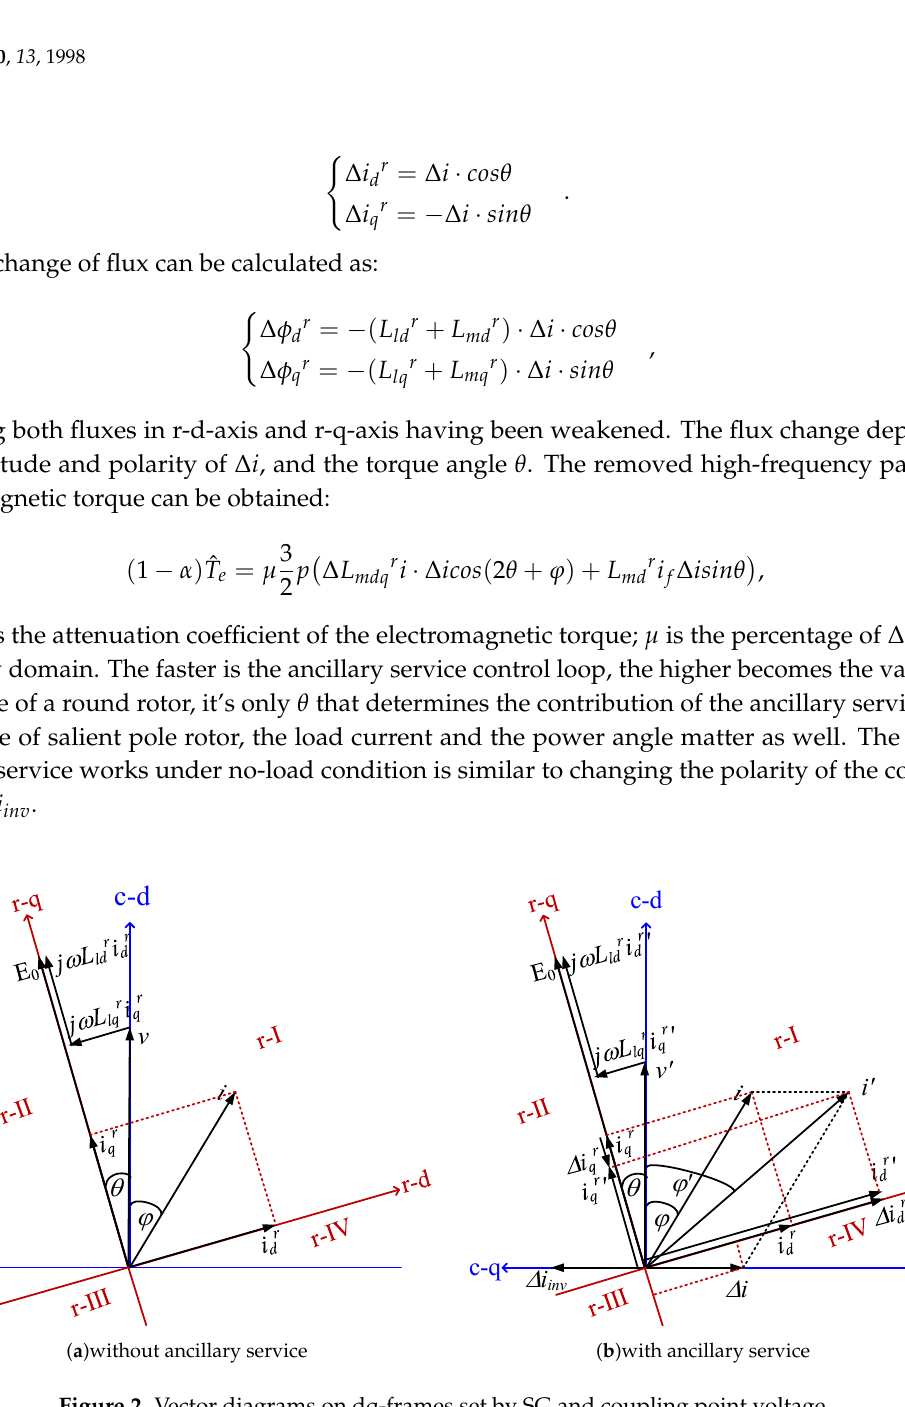
Figure 2. Vector diagrams on dq-frames set by SG and coupling point